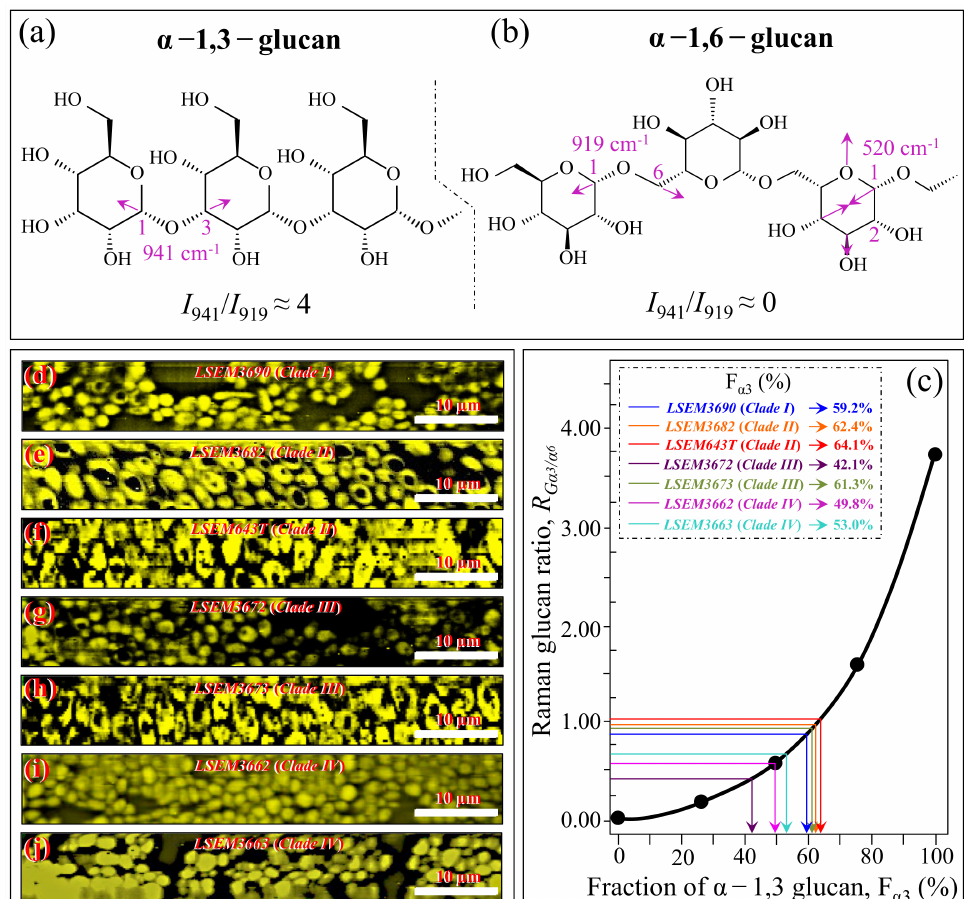
Figure 5. Molecular structure of ( a ) α –1,3–glucan and ( b ) α –1,6–glucan (with their respective Raman fingerprint vibrations); ( c ) Raman calibration plot of the R G α 3/ α 6 = I 941 / I 919 intensity ratio vs. fractions of α –1,3–glucan, F α 3 (data from data in Ref. [24]; ( d – j ): Raman images of the R G α 3/ α 6 ratio collected on different C. auris samples (cf. labels). The average R G α 3/ α 6 value for each image locates the respective F α 3 value on the calibration plot ( c ) (cf. values shown in inset given in